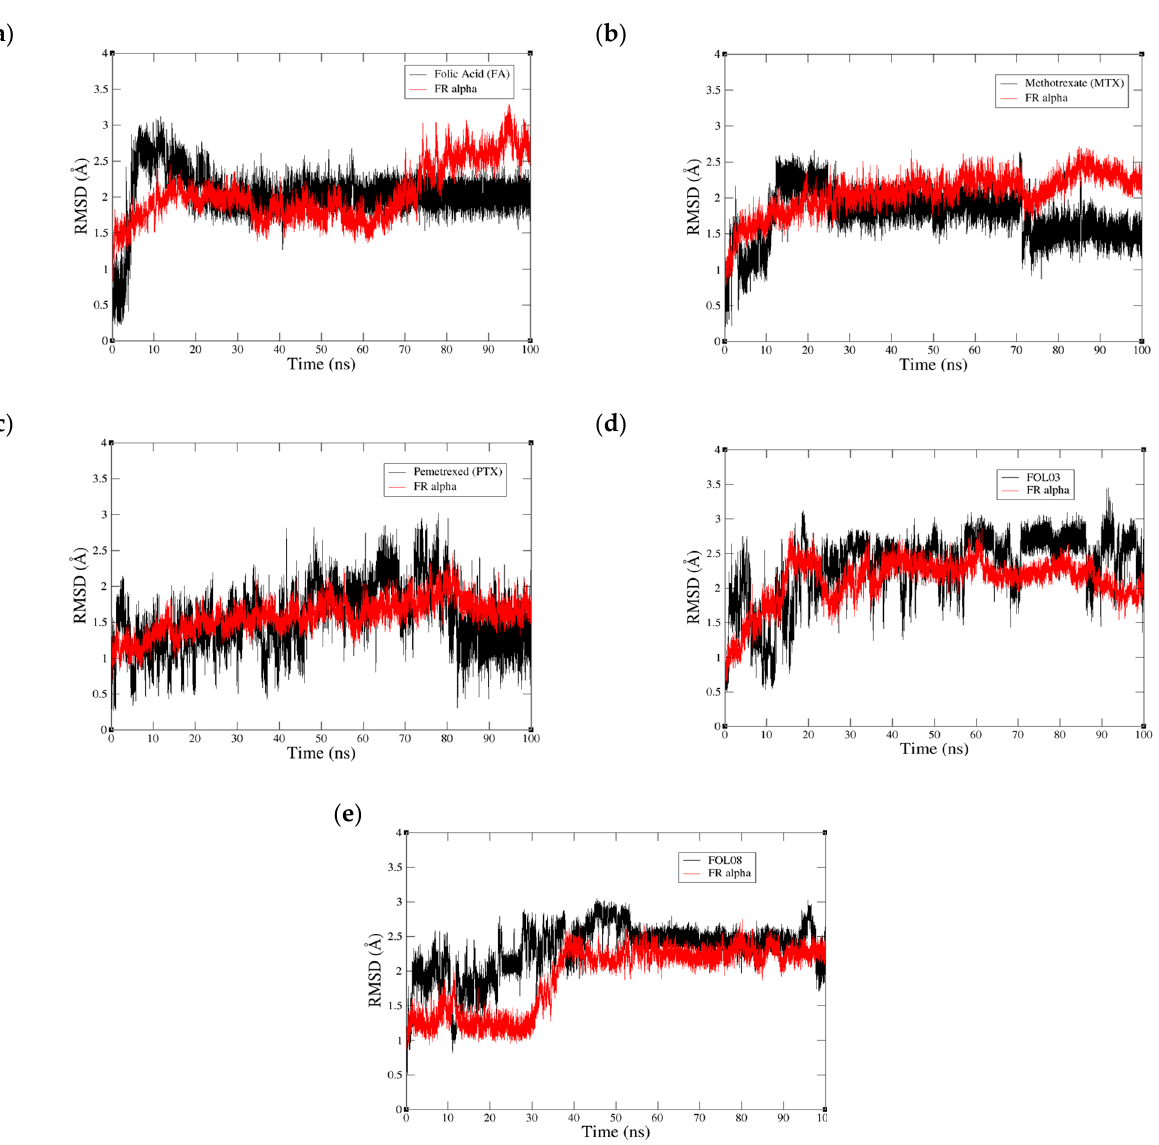
Figure 7. The root mean square deviation (RMSD) plots for the selected systems. ( a ) FR α –folic acid (FA), ( b ) FR α –methotrexate (MTX), ( c ) FR α –pemetrexed (PTX), ( d ) FR α –FOL03, and ( e ) FR α –FOL08. The ligands are in black and the FR α protein are in red.